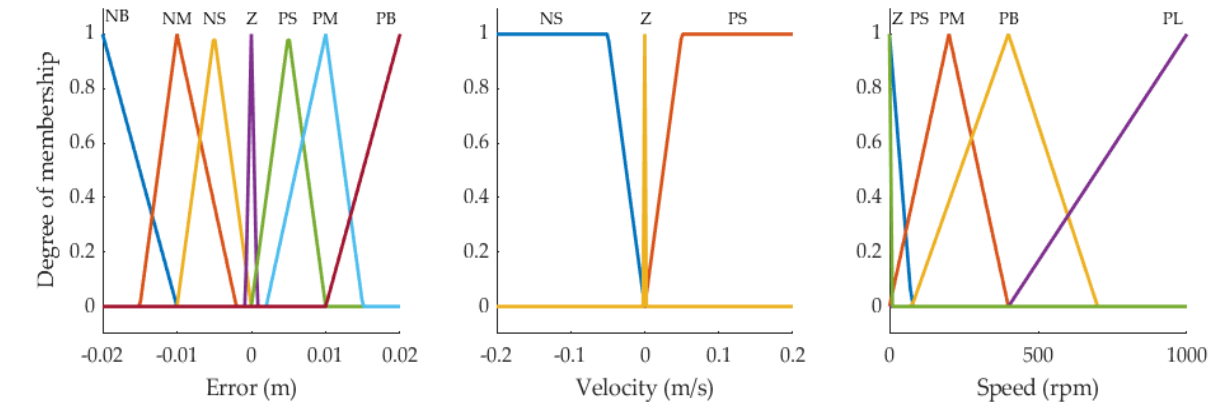
Figure 7. Membership functions of FLC for valve control.3.3. Switching modes. Table 3. Rule table of FLC for